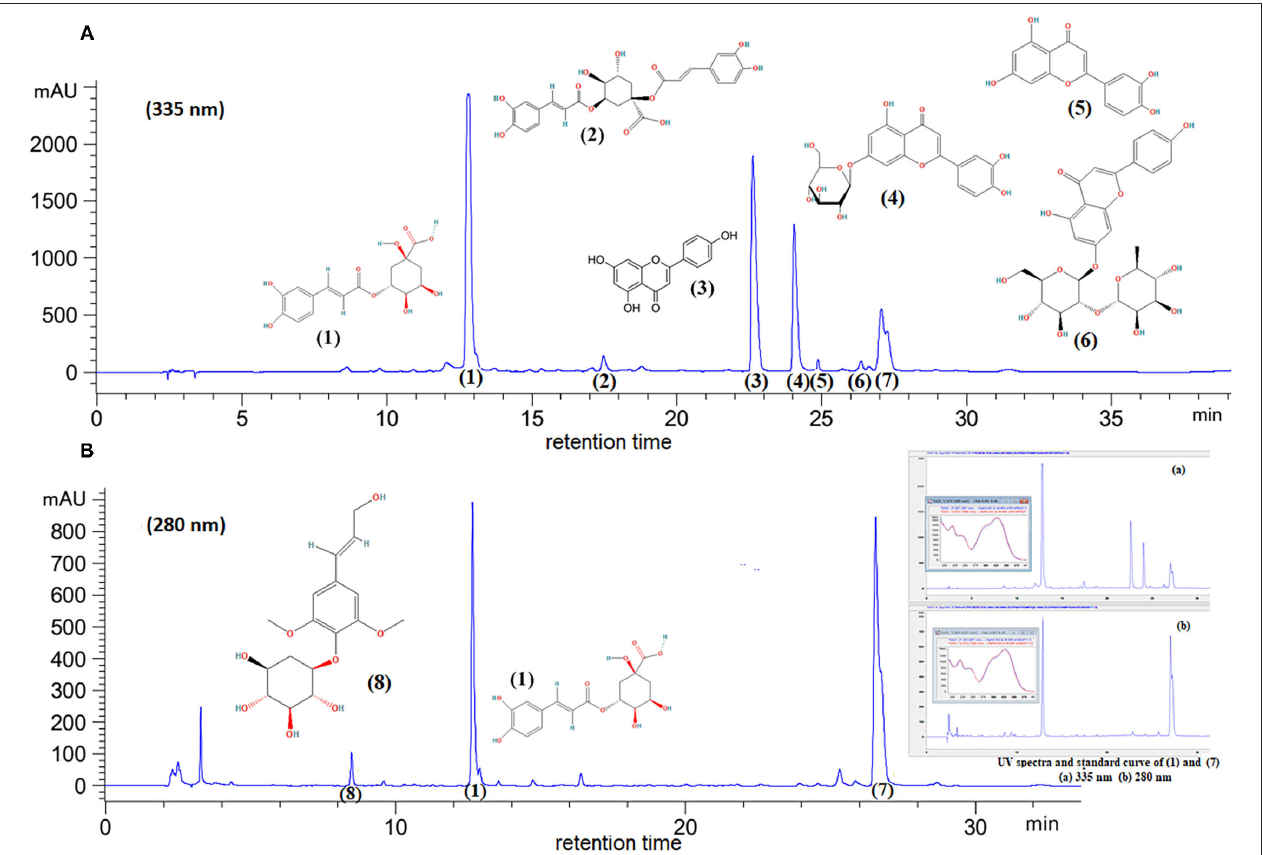
FIGURE 1 | (A) 335- and (B) 280-nm overlay of chromatograms from artichoke samples. (1) Chlorogenic acid, (2) cynarine, (3) apigenin, (4) cynaroside, (5) luteolin, (6) rhoifolin, (7) cholorogenic acid oxidation products, and (8) syringin.